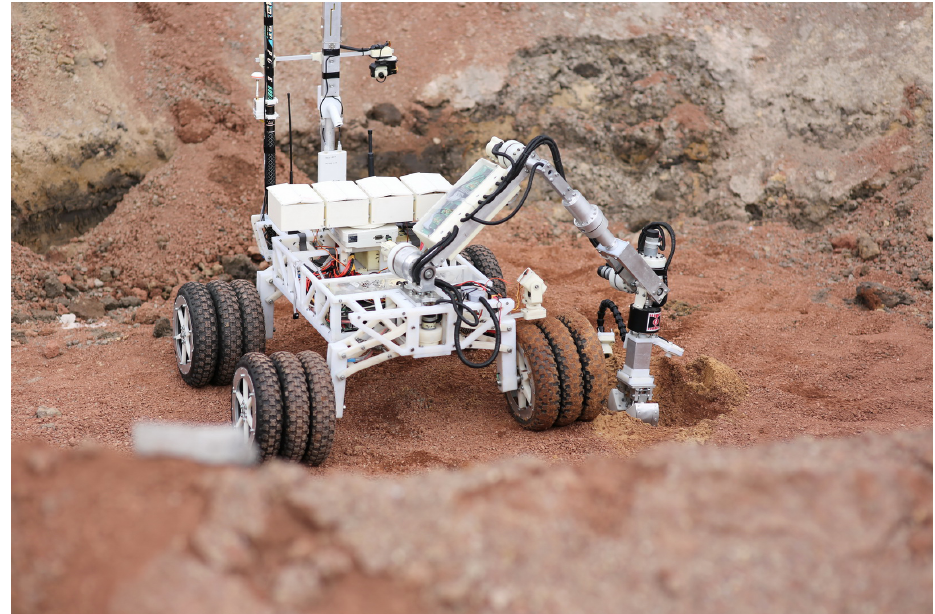
Figure 3. A photograph the vehicle with the implemented autonomous